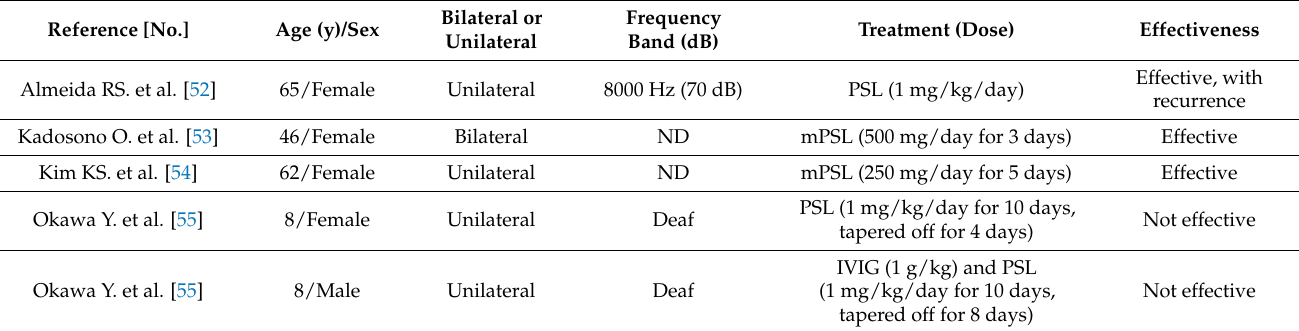
Table 2. Summary of the case reports on treatment of Sjögren’s syndrome with